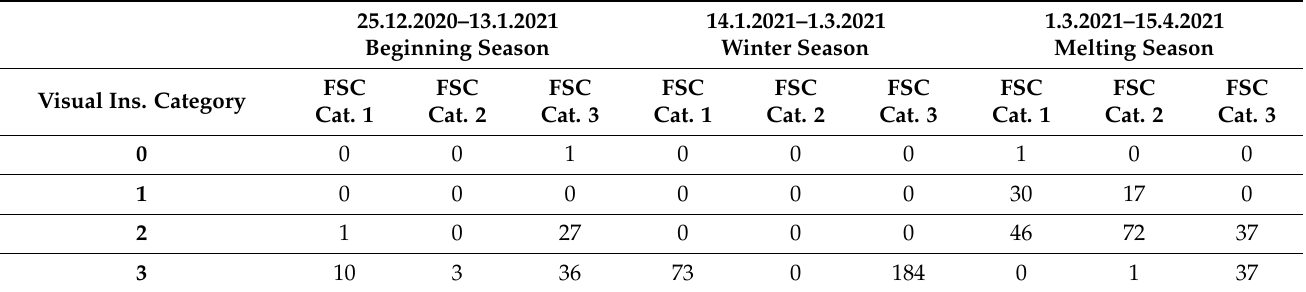
Table 3. The correspondence between visual inspection of snow presence and FSC data in Jokioinen (ROI the whole